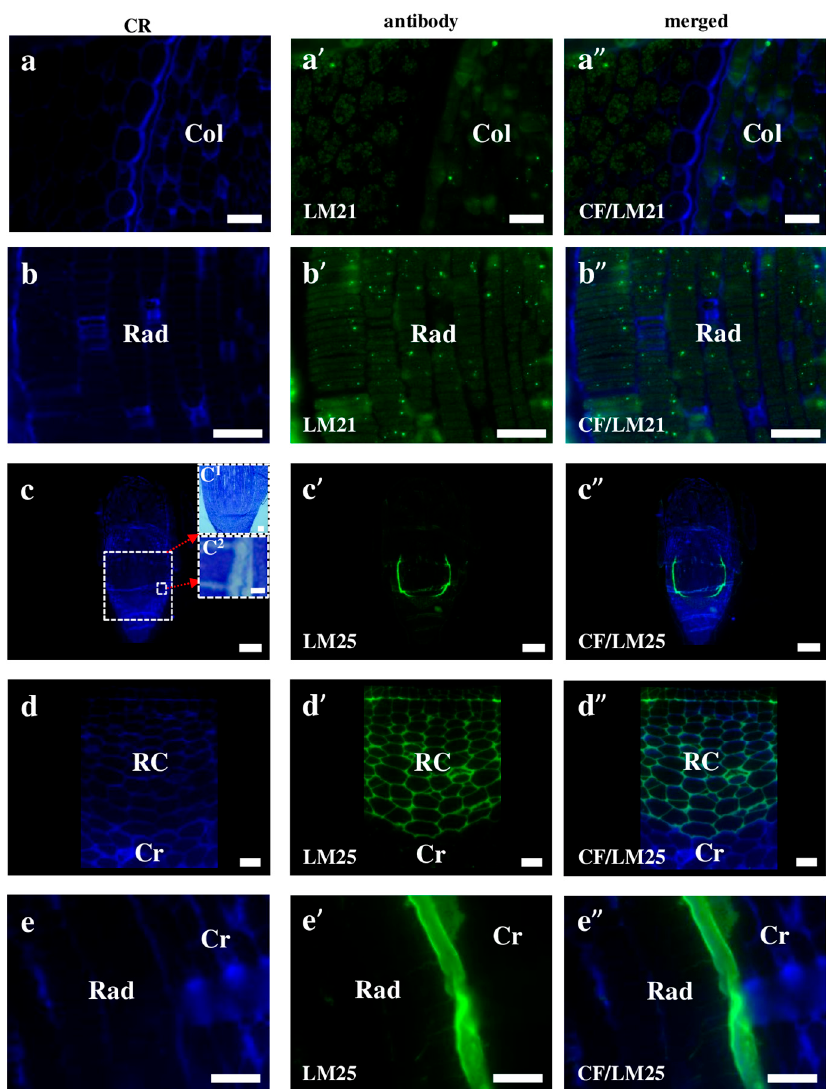
Figure 9. Immunolocalisation of hemicelluloses in Brachypodium embryos. ( a – a” ) coleoptile; ( b – b” ) radicula with LM21, respectively; ( c – c” , d – d” , e – e” ) the entire embryo, root cap with coleorhiza and radicula with coleorhiza with LM25, respectively. Arrows demonstrate insets: ( c 1 , c 2 ) histological sections of embryo, scale bars are 50 and 2 µm, respectively. Abbreviations: CF—calcofluor, Col—